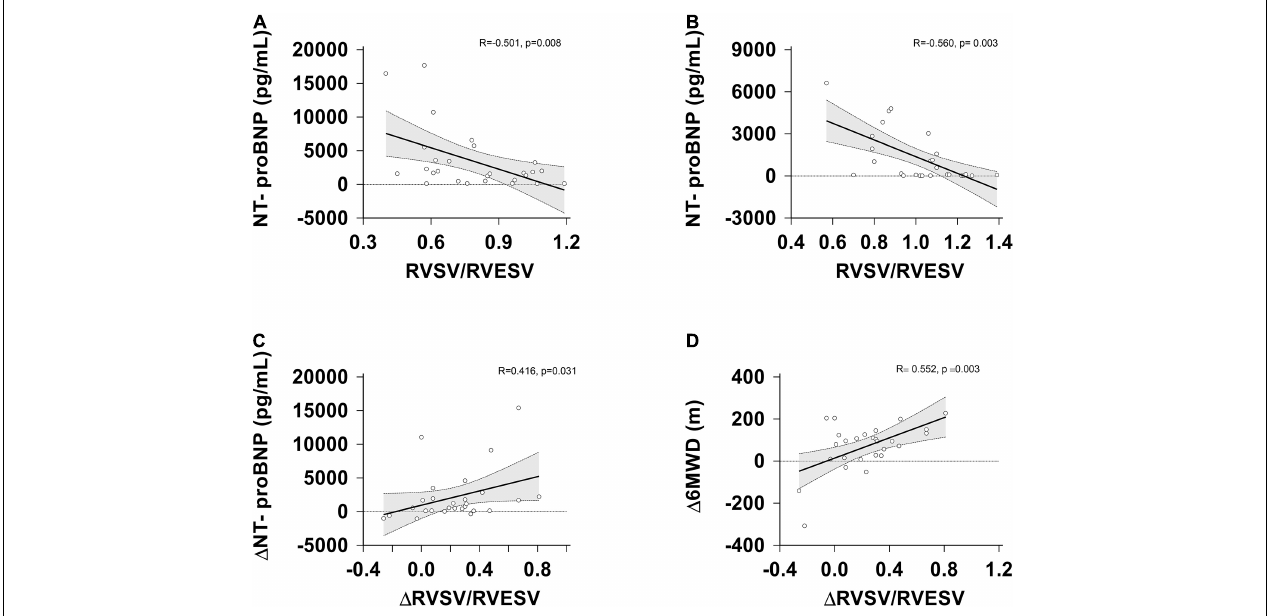
FIGURE 4 | Correlation between RVSV/RVESV, (cid:52) RVSV/RVESV, NT-proBNP, (cid:52) NT-proBNP and (cid:52) 6MWD at the baseline and follow-up assessment. (A) RVSV/RVESV vs. NT-proBNP levels at the baseline; (B) RVSV/RVESV vs. NT-proBNP levels at the follow-up; (C) changes in RVSV/RVESV vs. changes in NT-proBNP levels. (D) changes in RVSV/RVESV vs. changes in the 6MWD. (cid:52) , change; RVESV, right ventricular end-systolic volume; RVSV, right ventricular stroke volume; NT-proBNP, N-terminal pro B-type natriuretic peptide.